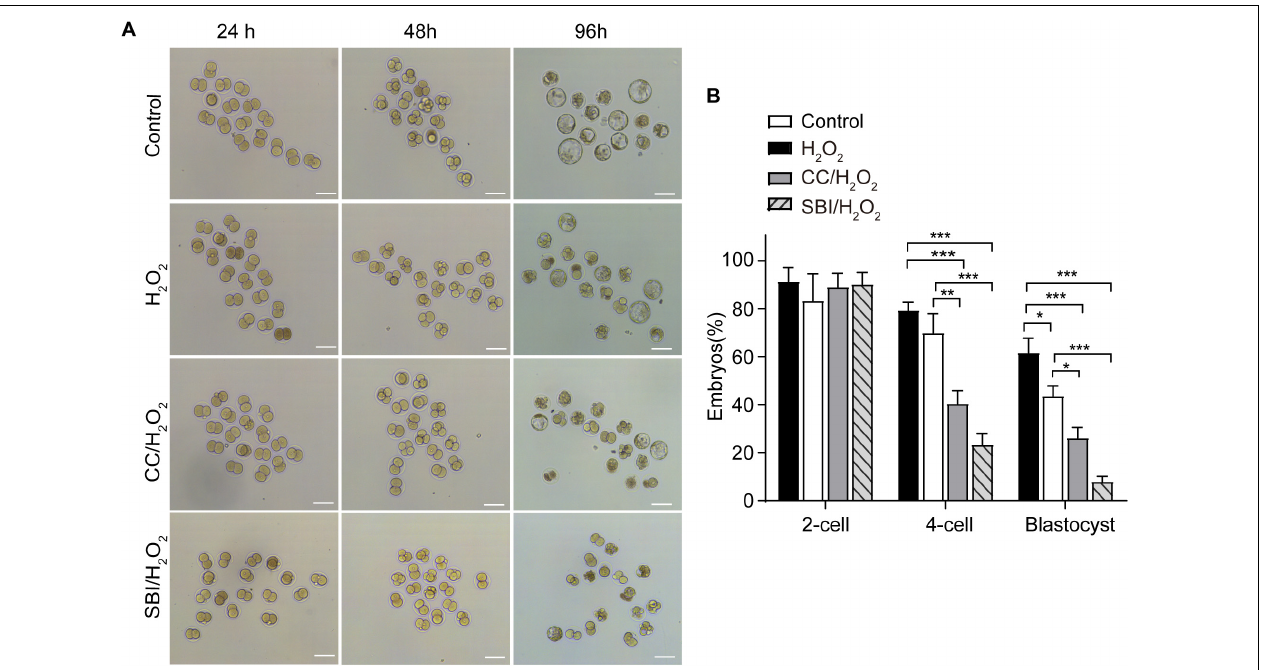
FIGURE 7 | Inhibition of AMPK activity affected the development of mouse embryos under mild oxidative stress. CC, Compound C; SBI, SBI-0206965. (A) Representative image of embryos at 24, 48, and 96 hpi, coinciding with the formation of 2-cell embryos, 4-cell embryos, and blastocysts. Scale bars = 100 µ m. (B) Statistics of 2- cell, 4- cell and blastocyst formation rate. More than 150 embryos in each experiment were counted ( n = 3). Results were analyzed by one-way ANOVA and Tukey’s test. * p < 0.05; ** p < 0.01; *** p < 0.001. Error bars: SD.